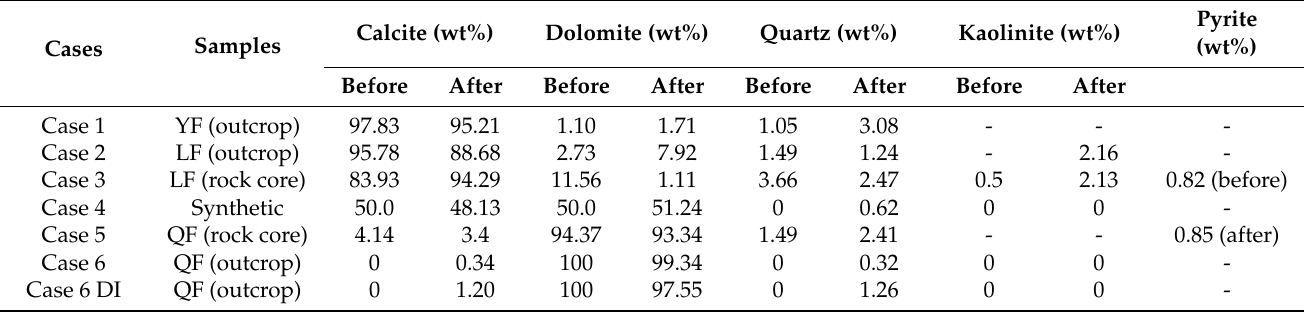
Table 6. XRD results of the rock samples before and after the